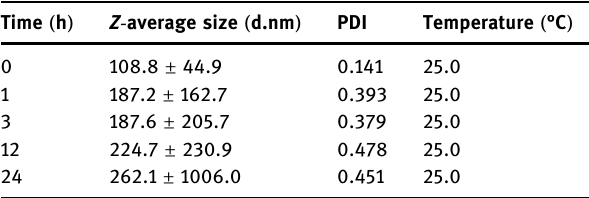
Table 1: The particle size of DOX - GSH - PEG micelle in esterase circumstance Time ( h ) Z - average size ( d.nm